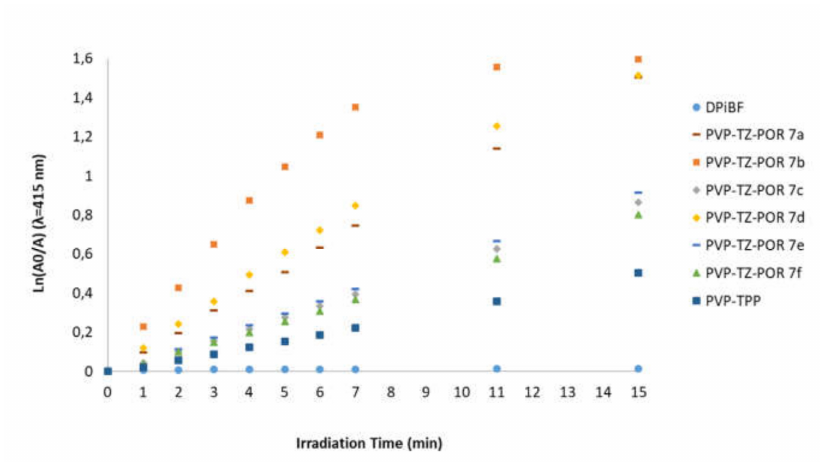
Figure 2. Photodecomposition of DPiBF (50 µ M) photosensitized by PVP-TZ-POR 7a – f and PVP-TPP in DMF:H 2 O (9:1) upon irradiation with white light filtered through a cut-o ff filter for wavelengths < 550 nm, with an irradiance of 20 mW / cm –2